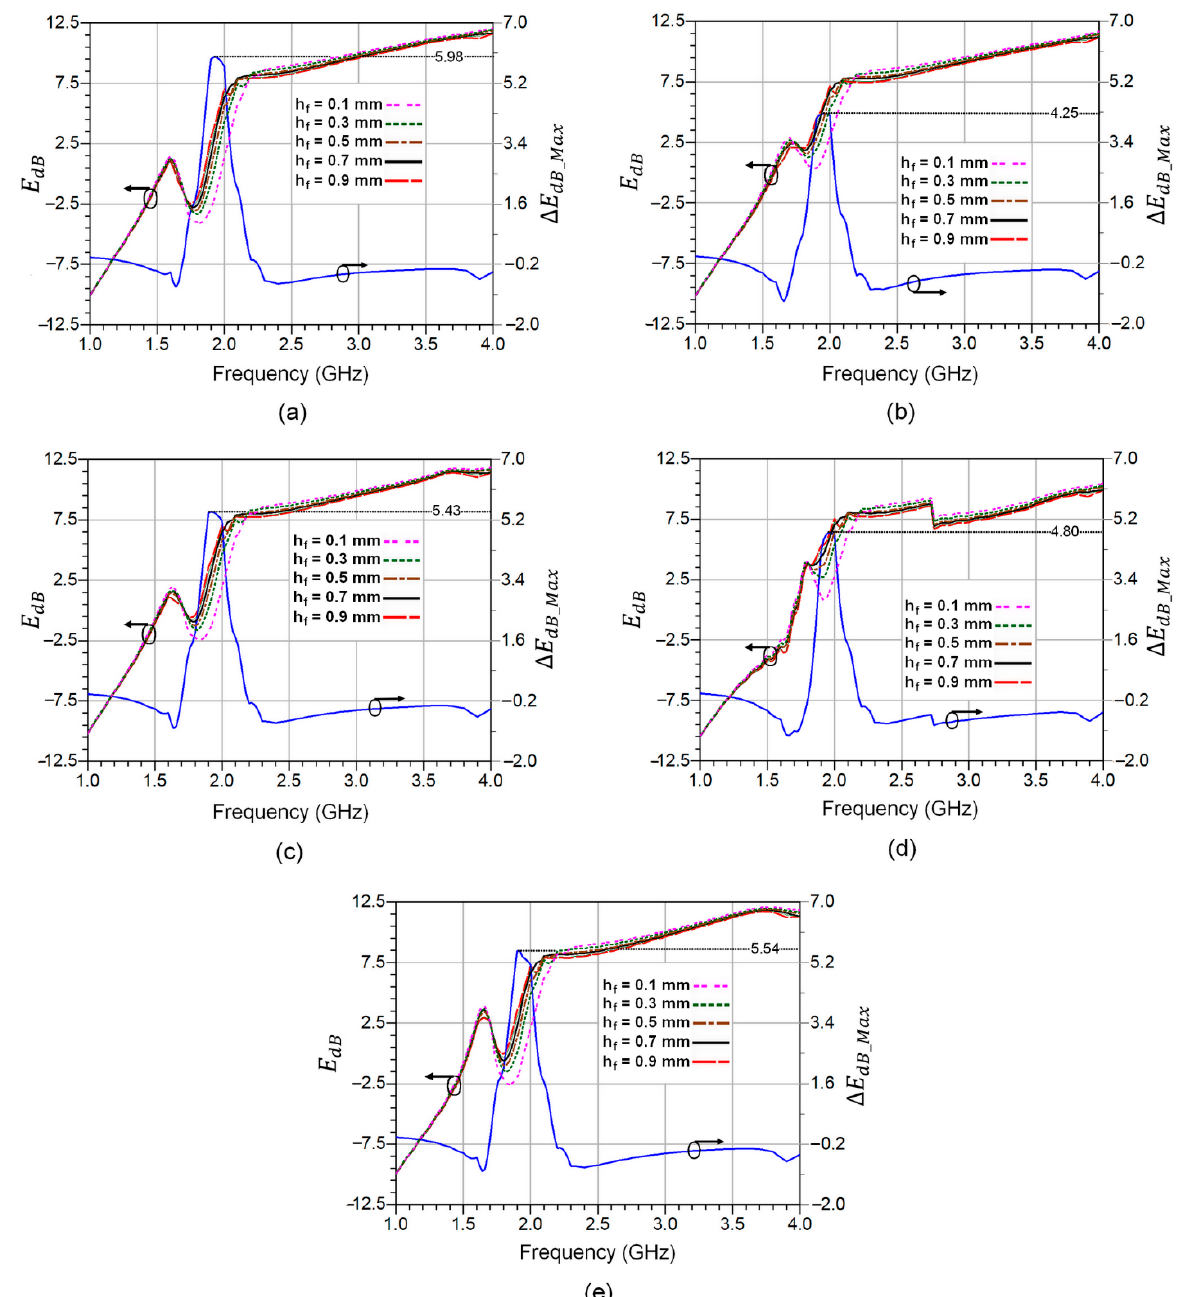
Figure 8. The error E dB and the maximum error ∆ E dB_Max for all five fingertips at different fat thicknesses as a function of frequency: ( a ) Thumb finger; ( b ) Index finger; ( c ) Middle finger; ( d ) Ring finger; and ( e ) Pinky finger.